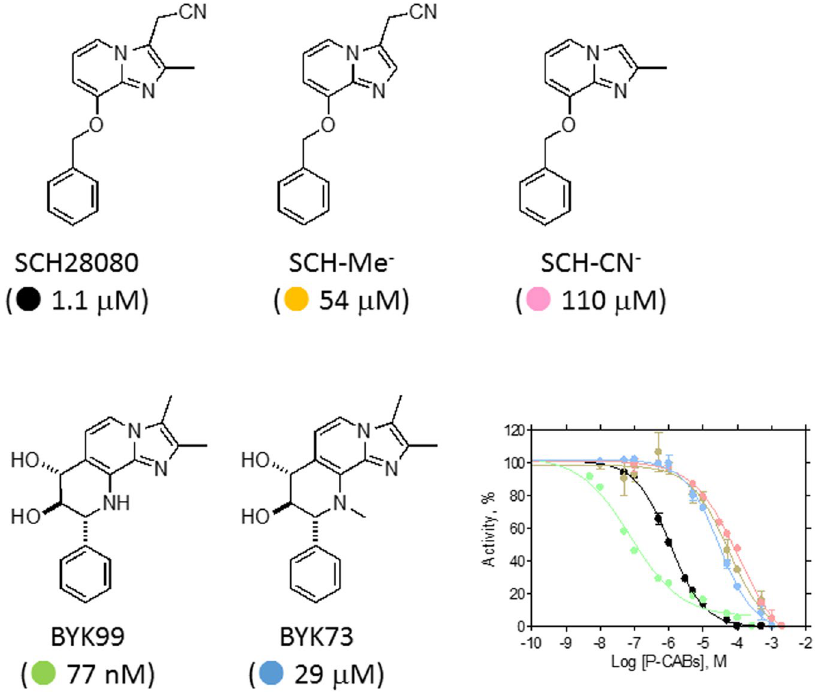
Figure 1. Chemical structures of SCH28080 and its derivatives. Chemical structures of SCH28080 and its derivatives used in this study are represented. Abbreviations for each compound are indicated. Dose-dependent inhibition of H + ,K + -ATPase activity by these compounds in the presence of 10 mM KCl is shown in the graph. The half-inhibitory concentration of each compound at this K + concentration ( IC 50 ) is indicated in